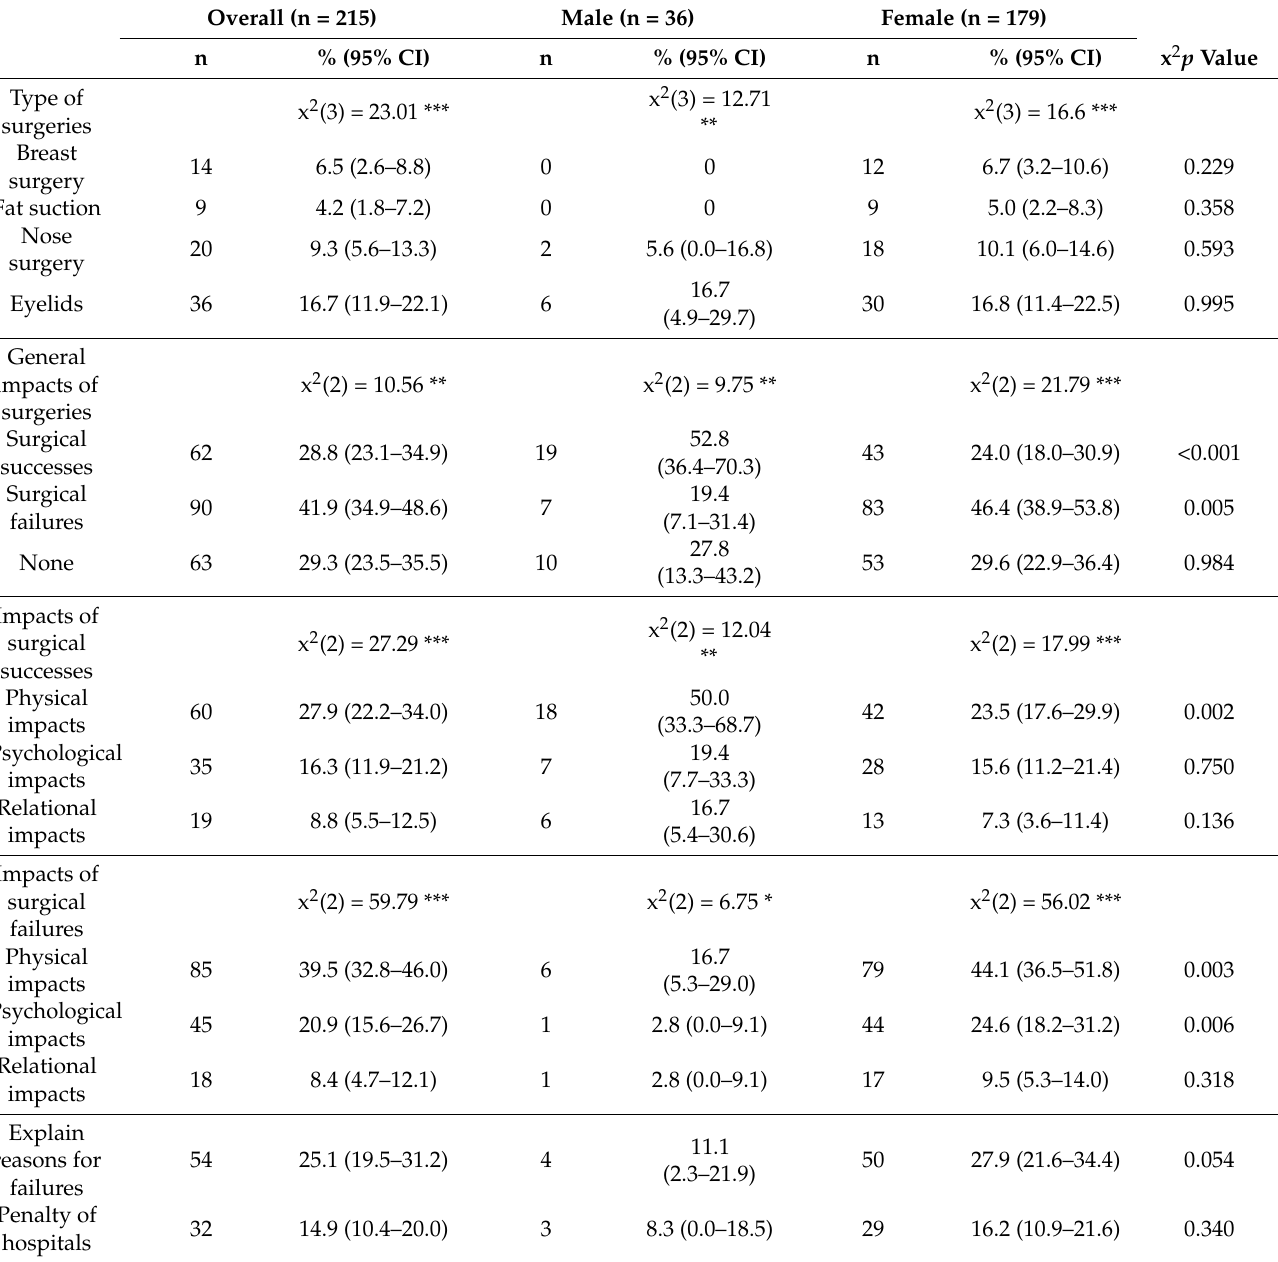
Table 2. Newspaper reporting on patient